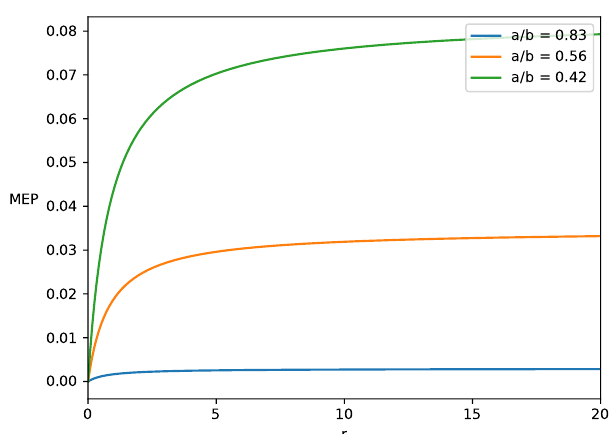
Figure 1: The mean entropy production rate for a = 0.5, increasing as function of the rocking rate r . The limiting process r ↑ ∞ is a reversible Markov process not satisfying LDB. The value b is decreasing from the top ( b = 1.2) to the top curve ( b = 0,6). The MEP vanishes for a = b = 0.5. Figure courtesy Simon